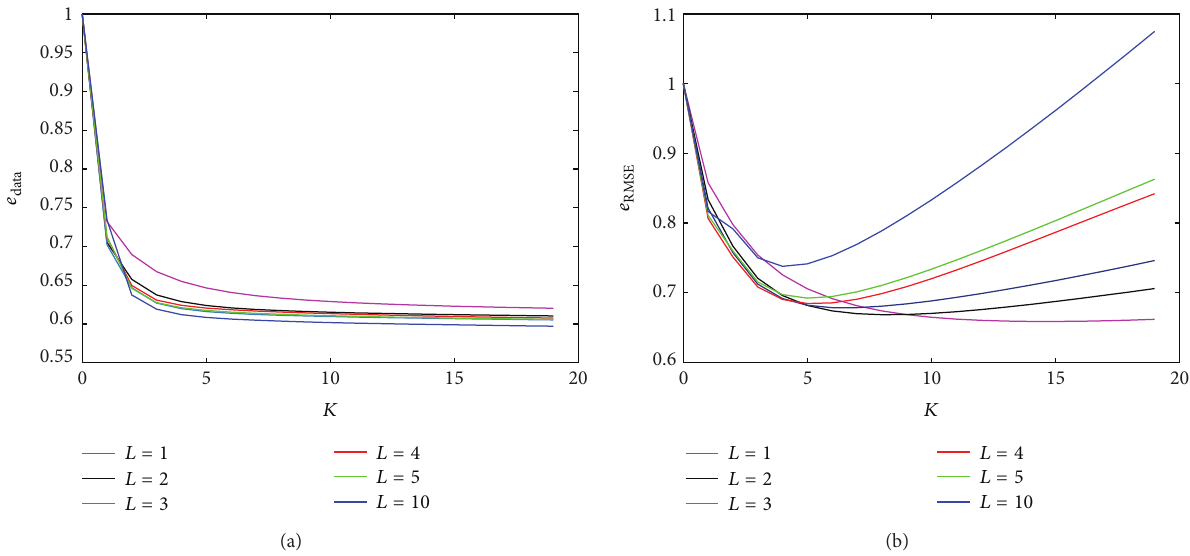
Figure 2: Error measures versus the number of outer iterations for different values of the number of inner iterations. Homogeneous dielectric cube. SNR = 20 dB.